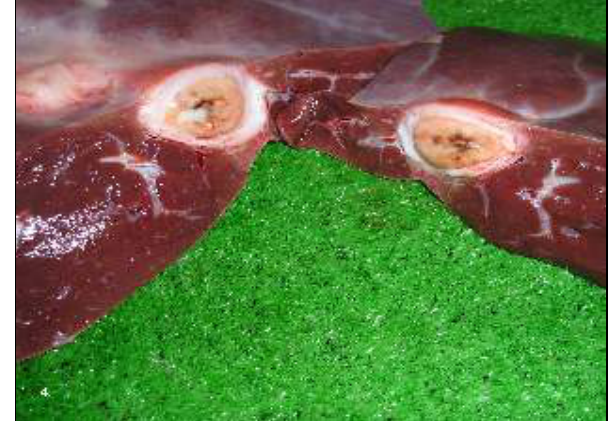
th Figure-3: Ultrasonography of liver at right 9 ICS shows a Figure-4: Post mortem finding of a cattle shows a cut section in abscess which appears as circumscribed pus-filled structure with a thick capsule.